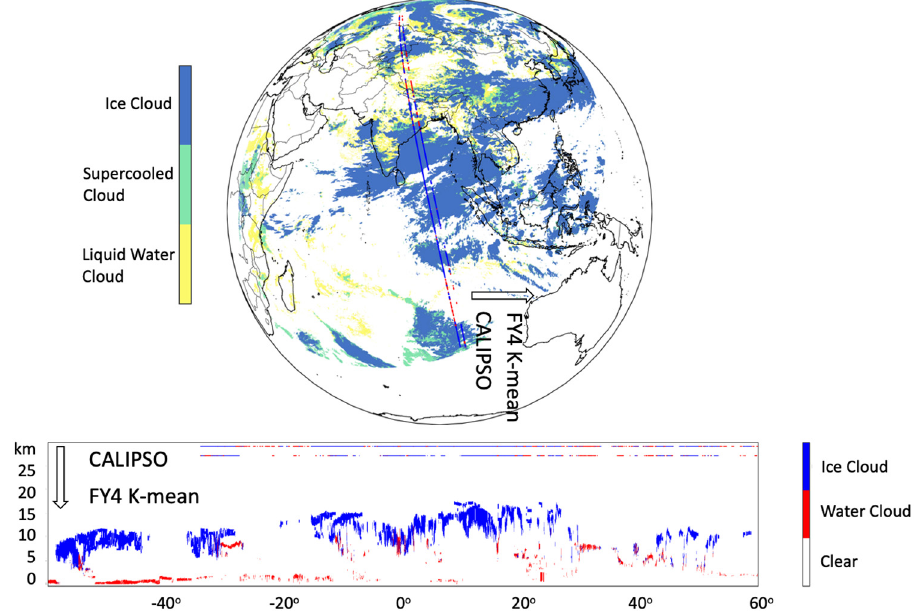
Figure 5. The FY-4A cloud top phase validated against CALIPSO VFM production at 07:00 UTC on 25 June 2017.